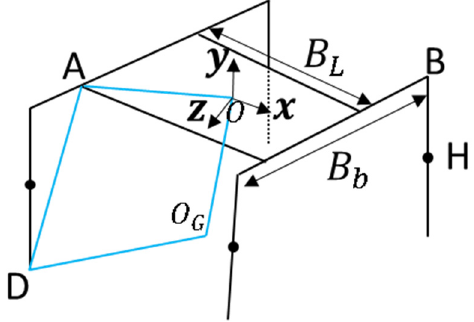
Figure 12. Vector diagram of robot body posture control.